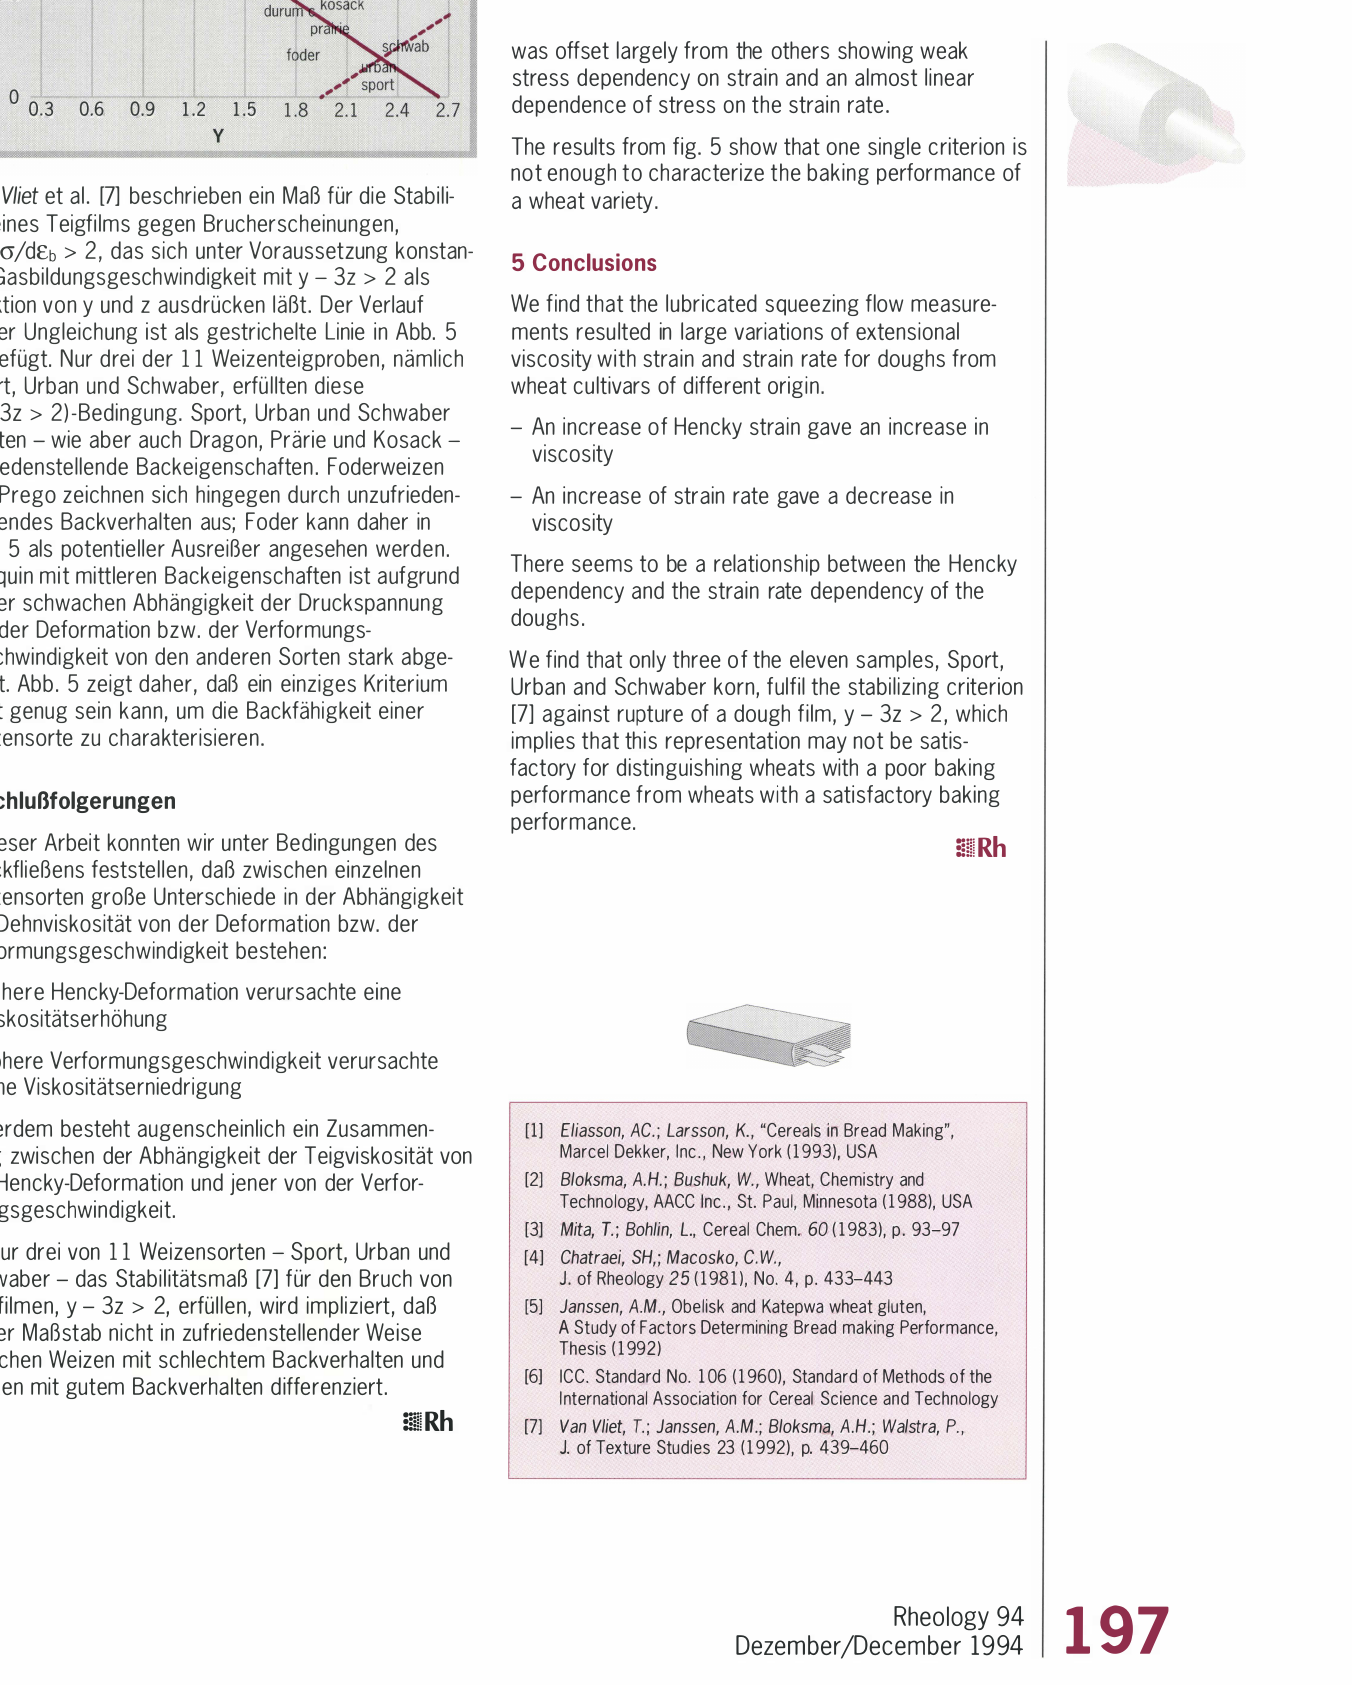
Fig. 5: y versus z calculated suitable to eqn. (6} for the eleven wheat cultivars